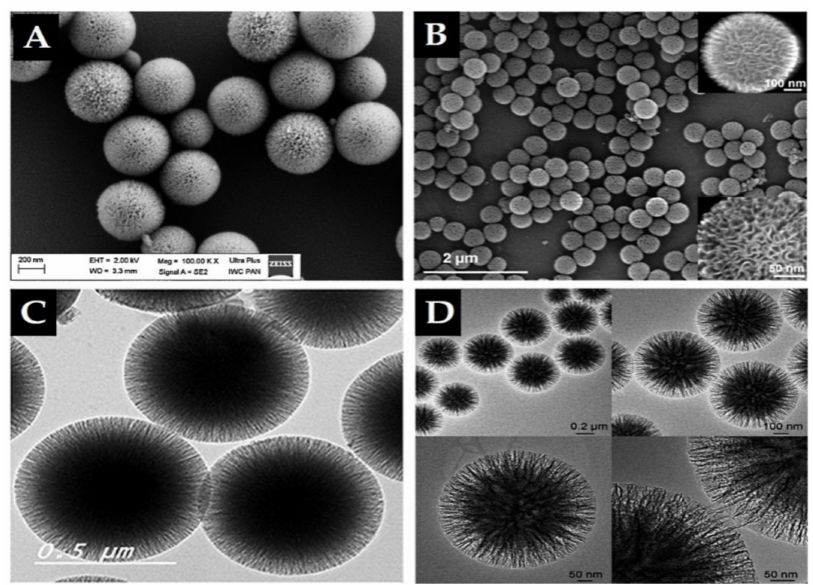
Figure 4. Electron microscope images of prepared KCC-1 material. ( A , B ) Scanning electron mi- croscopy (SEM). ( C , D ) Transmission electron microscopy (TEM). Note, the dendritic fibrous 3D mesopore structure is clearly seen by SEM in B. A and C reproduced from [42,43], Impact Journals, 2018 and MDPI, 2020. B and D reproduced with permission from [59], WILEY-VCH Verlag GmbH